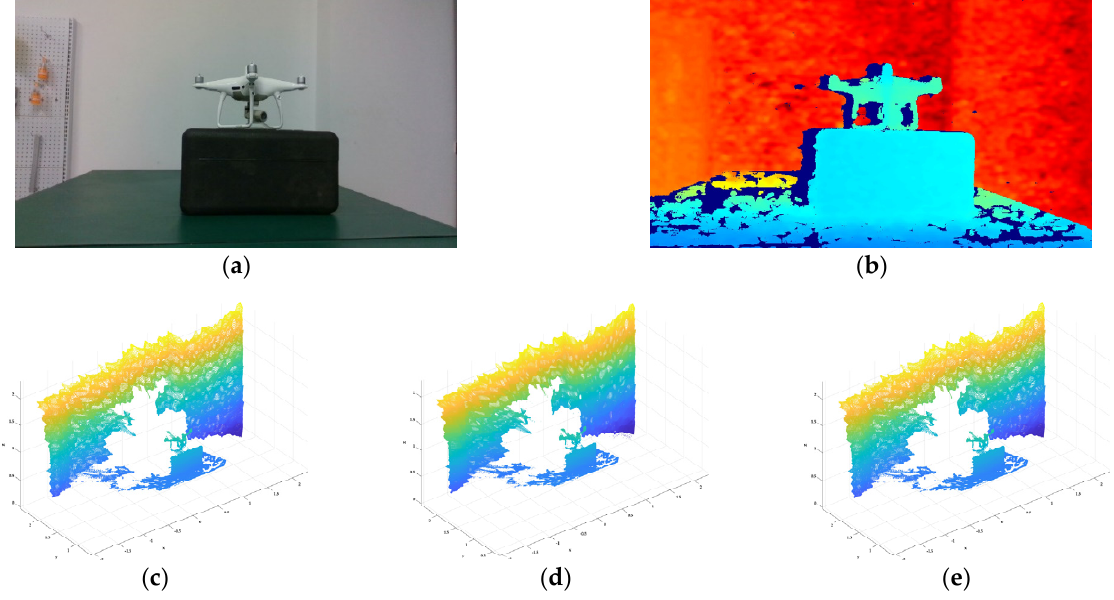
Figure 15. Denoising effects of fractional integral denoising and median filtering. ( a ) RGB image; ( b ) deep pseudo-colour map; ( c ) noise-free point cloud image; ( d ) point cloud image of the depth image filtered by the fractional integral denoising ( ν = − 0.3, PSNR = 53.764 dB); and ( e ) point cloud of the depth image after median filtering and denoising (PSNR = 34.708 dB).